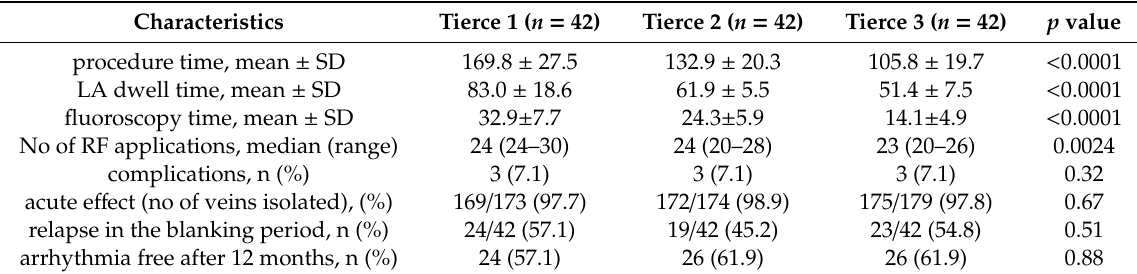
Table 2. Procedural characteristics, complications and